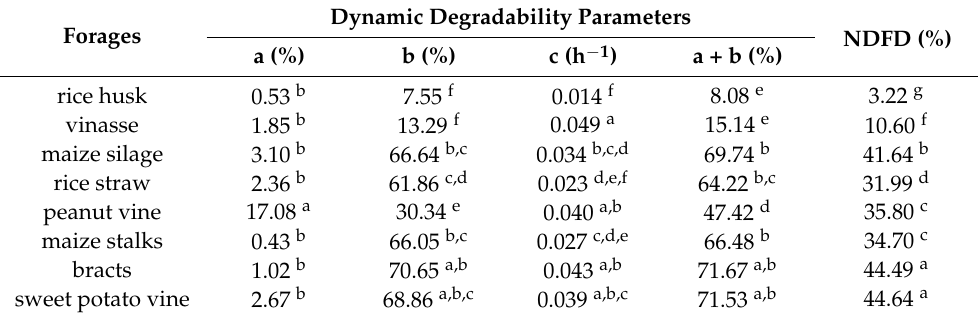
Table 1. The effective degradability of neutral detergent fiber (NDFD) in nylon bags of 8 kinds of roughage.